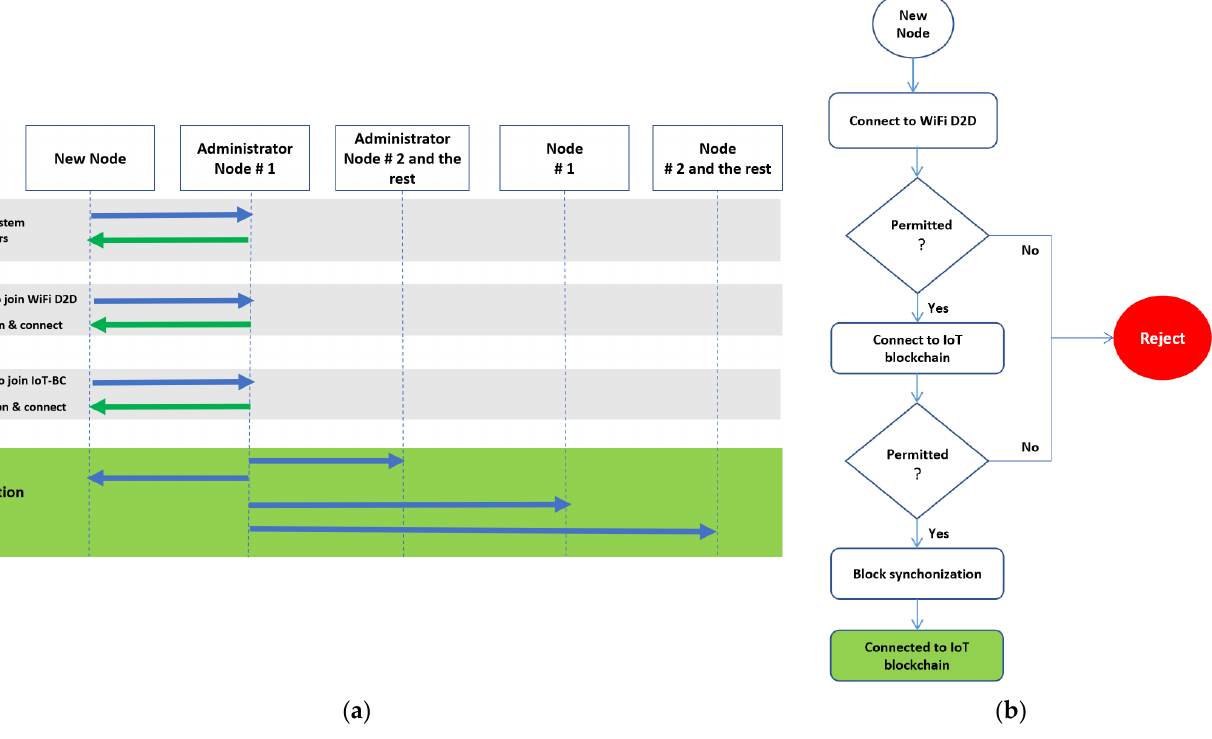
Figure 3. New node joining IoT blockchain: ( a ) Process flow; ( b ) Flow diagram.